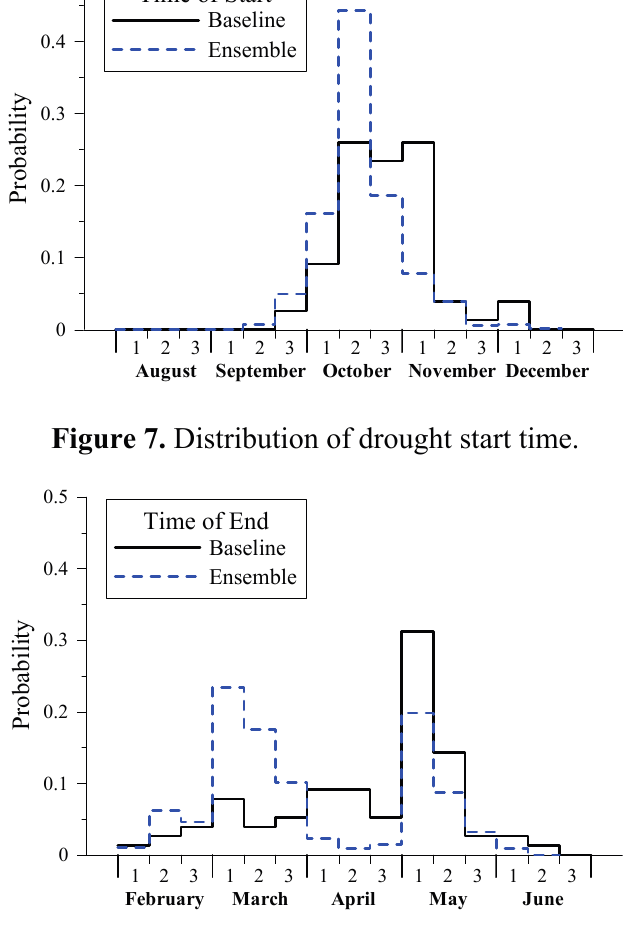
Figure 8. Distribution of drought end